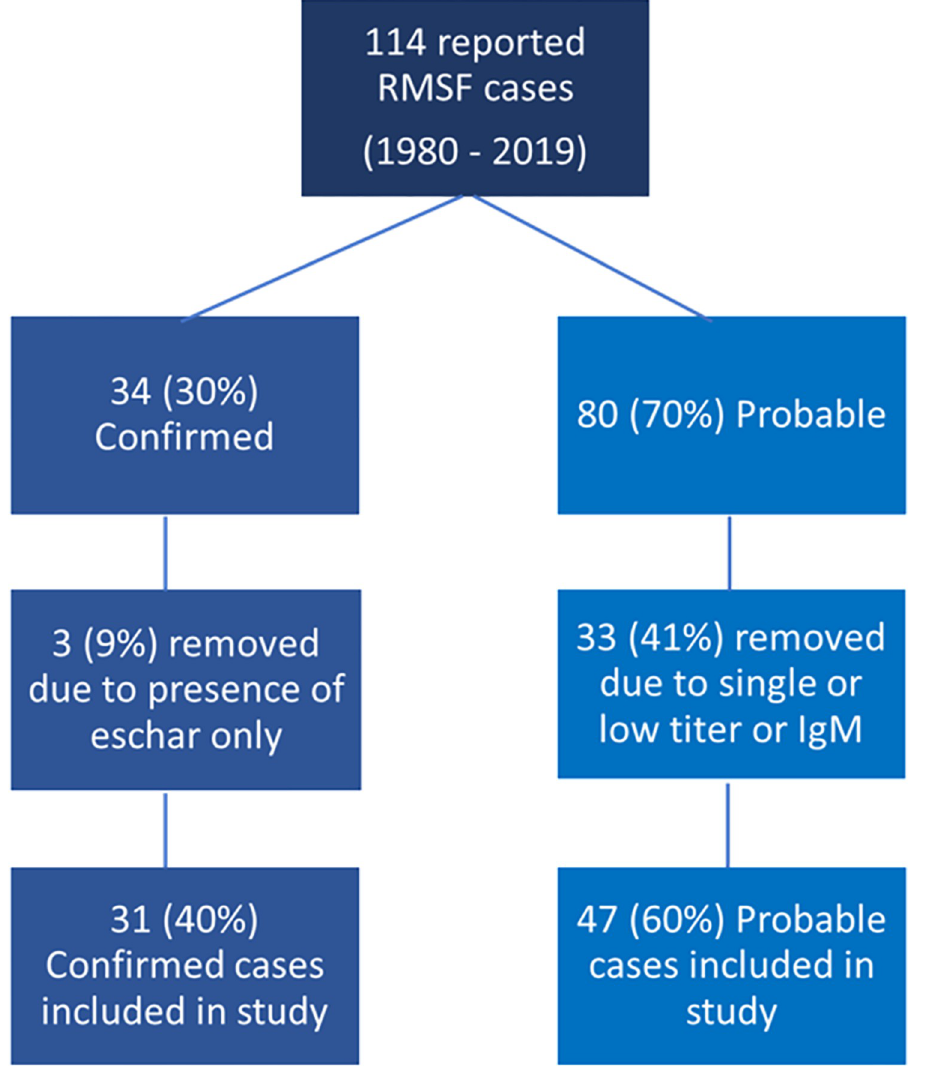
Fig 1. Flow of case evaluation for inclusion in this analysis. Case reports retrieved from 1980 to 2019 include all those reported as Rocky Mountain spotted fever (RMSF). Conservative case inclusion criteria were applied